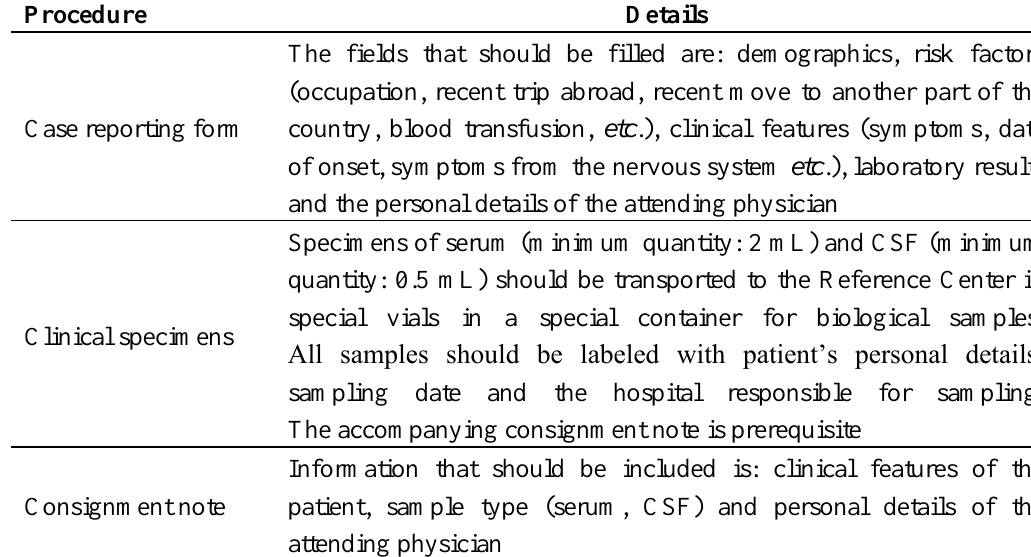
Table 5. Specimen sending for WNV diagnosis and case reporting